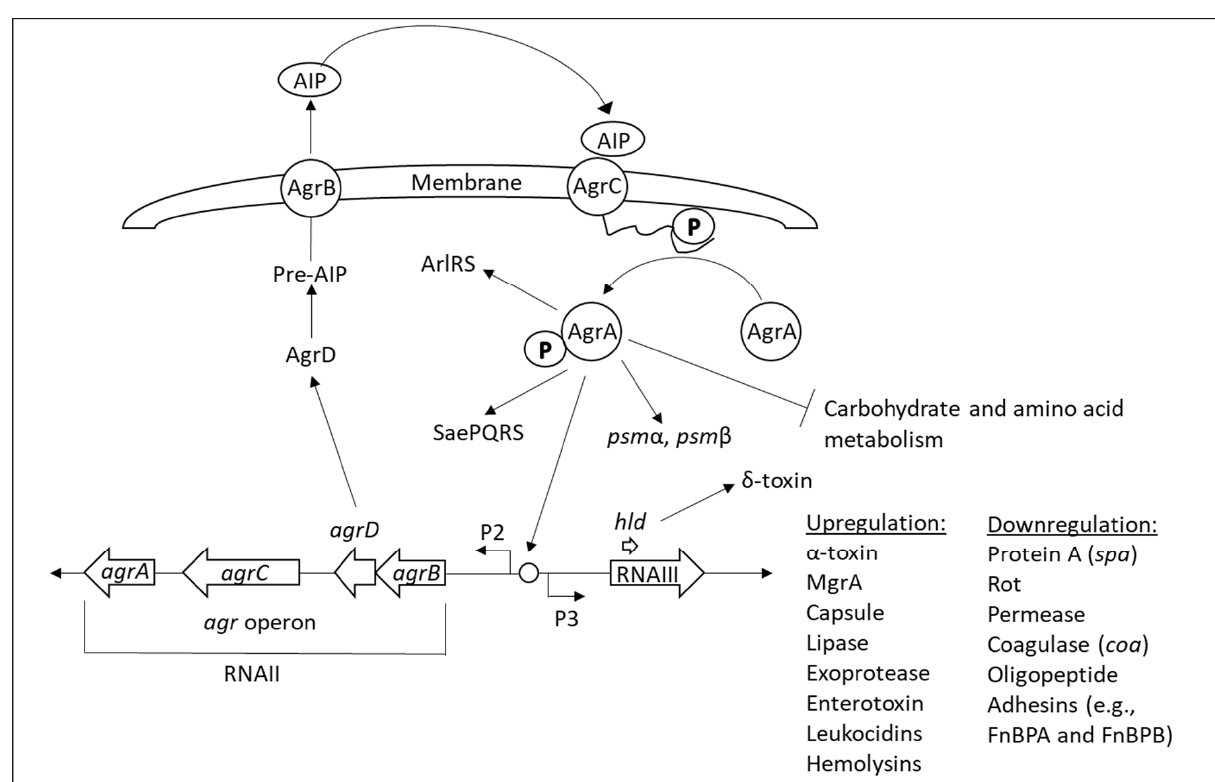
Figure 9. The Agr QS system of Staphylococcus aureus . The arg operon consists of the 4 genes: agrB , agrD , agrC , and agrA . AgrD encodes for a precursor of the autoinducer peptide AIP that is processed and transported through the cell membrane by AgrB. The mature AIP interacts with its receptor AgrC eliciting a phosphorelay, resulting in the phosphorylation and activation of the response regulator AgrA that affects the expression of multiple genes including the genes of the agr operon by binding to the P2 promoter, and the RNAIII regulatory RNA by binding to the P3 promoter. RNAIII affects the expression of a large number of genes, thereby promoting the virulence of Staphylococcus aureus . A small part of the RNAIII transcript encodes for the δ -toxin (delta-hemolysin ; hld ). Additionally, AgrA activates the TCSs ArlRS and SaePQRS, as well as upregulating the expression of the virulence factors phenol-soluble modulins (PSMs) alpha and beta. As shown in Figure 1B, ArlRS modulates the expression of the NorA efflux channel responsible for fluoroquinolone resistance and regulates virulence factors through the induction of MgrA. The SaePQRS TCS regulates the expression of various virulence factors.